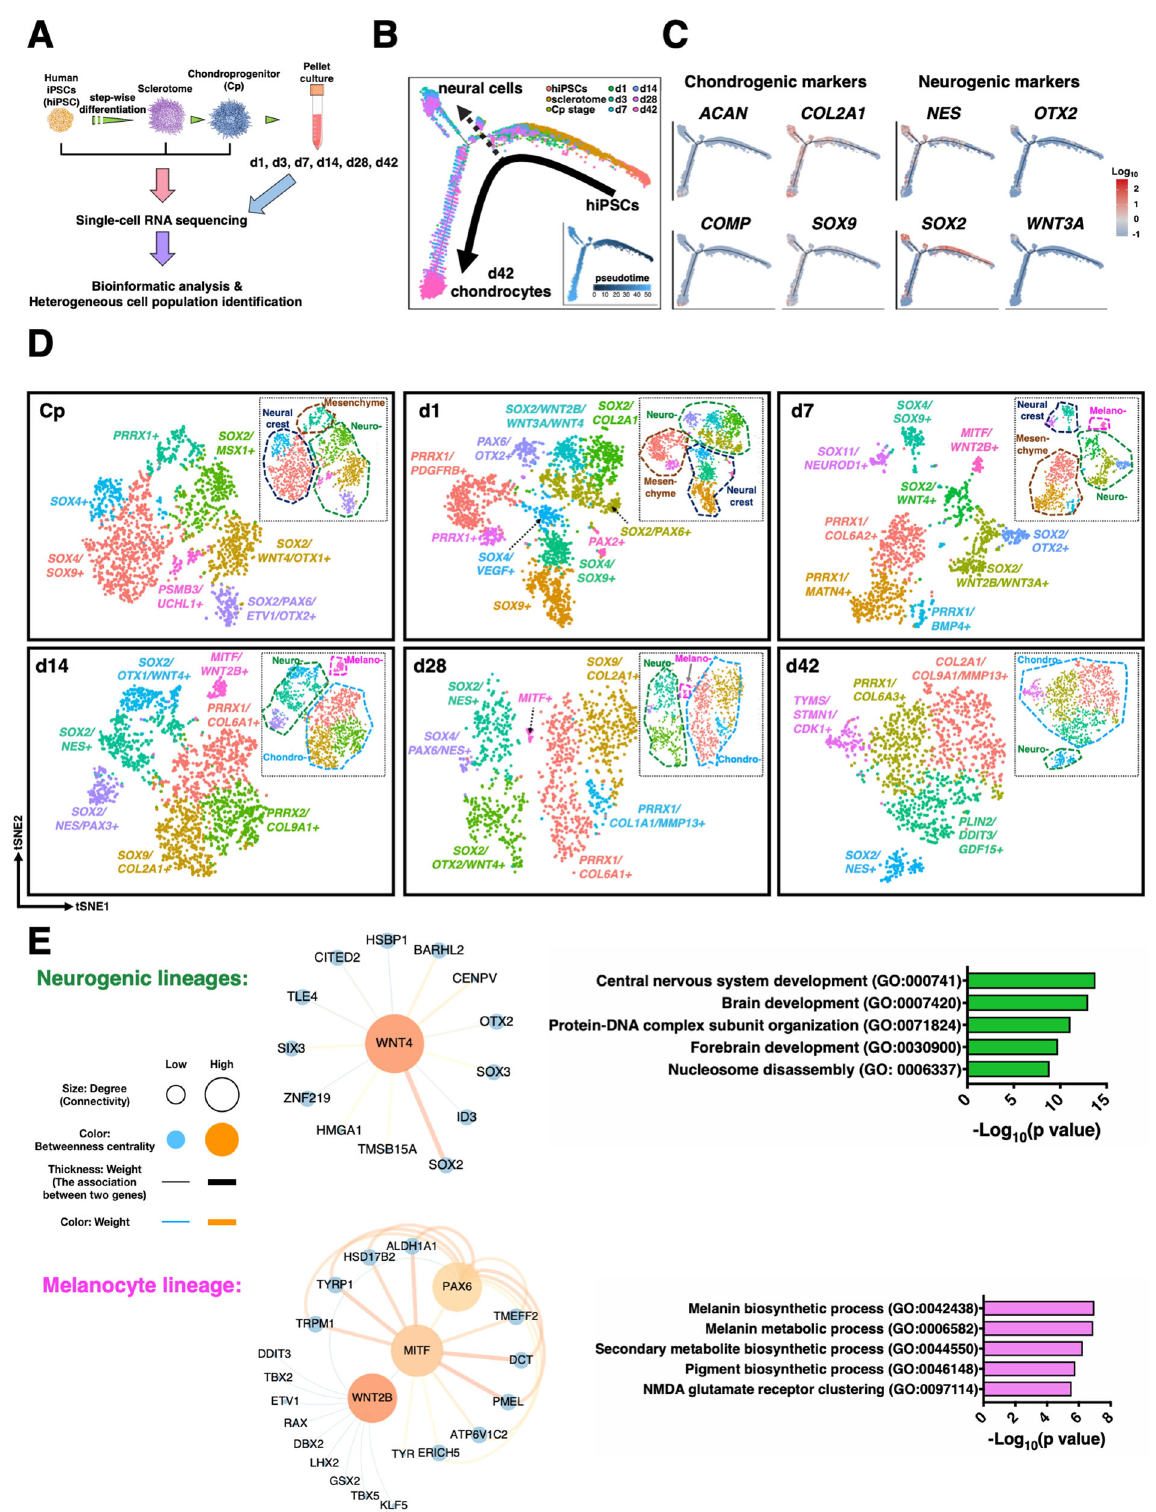
Fig. 3 scRNA-seq and WGCNA reveal neural cells and melanocytes as off-target cells. A scRNA-seq was performed at hiPSC, Sclerotome, Cp, and six chondrogenic pellet time points. B Reconstruction of differentiation trajectory reveals an off-target lineage bifurcation toward neural cells. A total of 19,195 cells that passed quality control from the stage of hiPSC to d42 chondrogenic pellet were used to reconstruct the differentiation trajectory. C Chondrogenic markers were enriched in the chondrogenic branch, while neurogenic markers were observed in the branch of neurogenesis. D Annotated cell populations at different time points during hiPSC chondrogenesis. Cells that passed quality are used for tSNE plots; Cp: 1888 cells, d1: 2216 cells, d7: 1200 cells, d14: 2148 cells, d28: 1271 cells, and d42: 1328 cells. E WGCNA and GO term analysis identi fi ed WNT4 as a hub gene of neurogenesis while WNT2B was highly associated with melanocyte development. scRNA-seq data of d14 pellets (with a total of 2148 cells and 3784 genes) was used for this